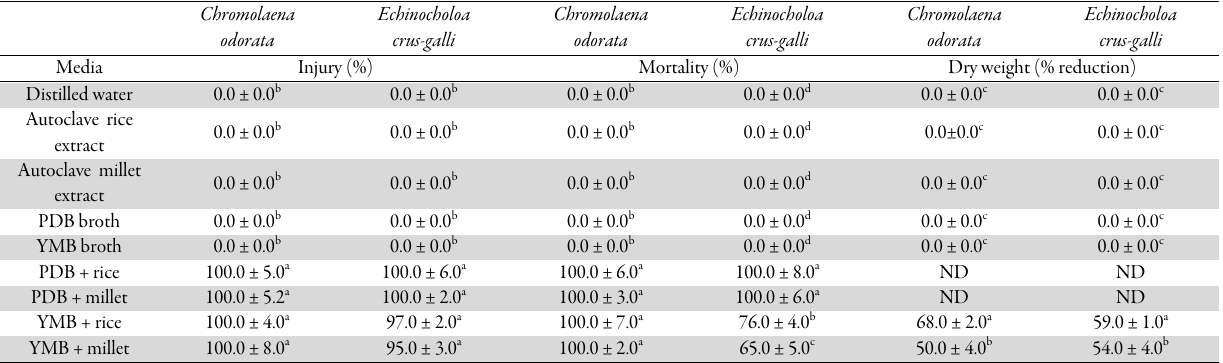
Table 1. Effect of herbicidal properties of the phytotoxic metabolite from strains of C1136 grown in a biphasic system on Chromolaena odorata and Echinocholoa crus-galli